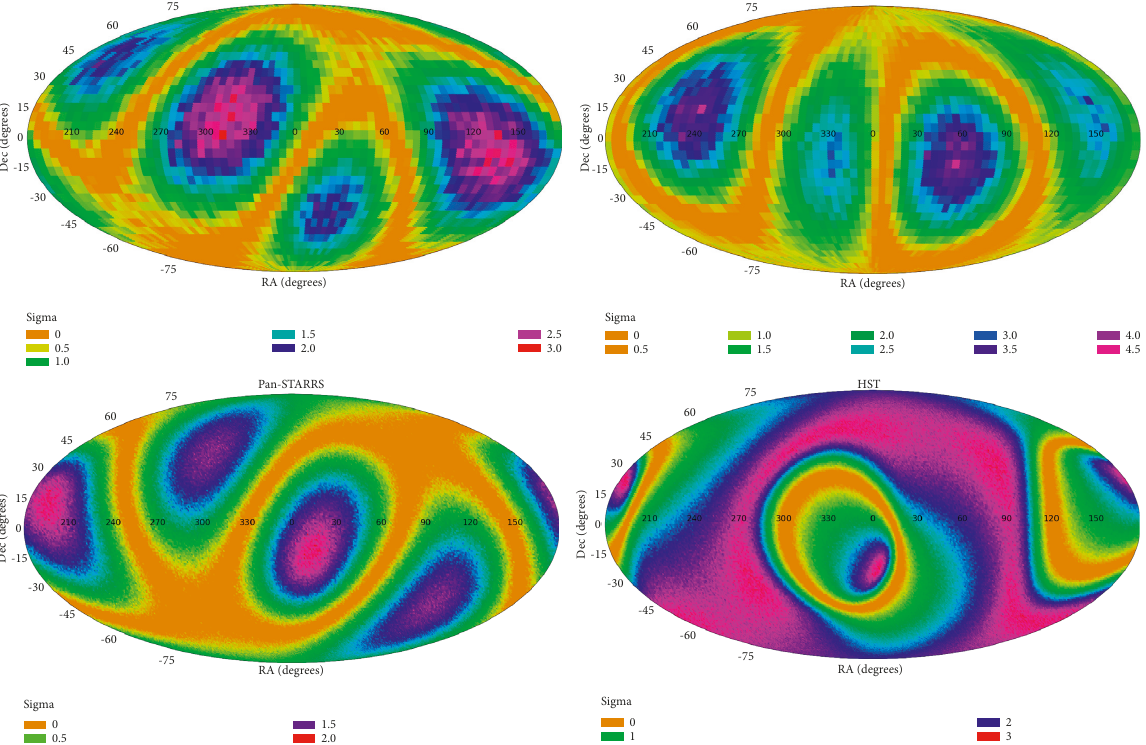
Figure 9: The probability of a quadrupole axis in the data acquired by DECam, Pan-STARRS, SDSS, and HST. The HSTdataset has a very small footprint and therefore not expected to provide an informative quadrupole